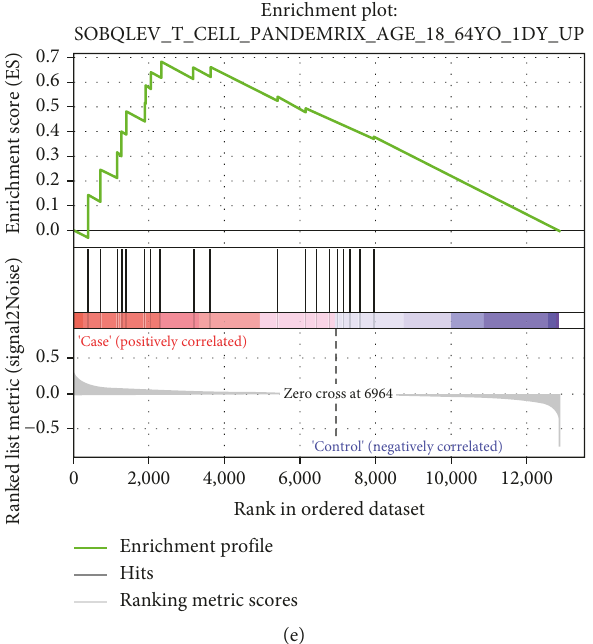
Figure 3: GSEA analysis of pathways related with HF based on dataset GSE5406. The gene sets of (a) Resting vs act cd4 tcell up, (b) Hoft cd4 positive alpha beta memory t cell bcg vaccine age 18–45 yo id 7dy top 100 deg ex vivo up, (c) Sobolev t cell pandemrix age 18–64yo 7 dy dn, (d) Nakaya pbmc fluad male age 14–27yo 1 d postboost vs 0d preimm mf59 adjuvanted 1dy genes in btm m40 and m53 dn, and (e) Sobolev t cell pandemrix age 18 64yo 1dy